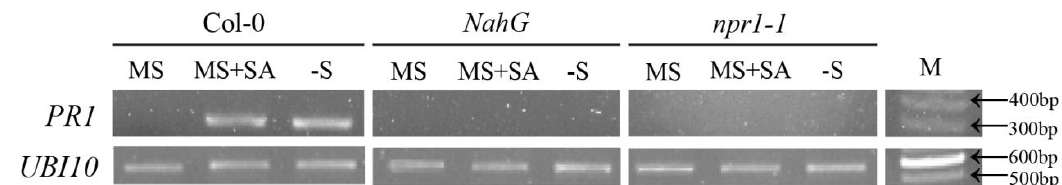
Figure 5. Gene expression analysis of PR1 in wild-type (Col-0), NahG and npr1-1 lines after treatment with ½ MS standard sulfur concentration and the sulfur deficiency (-S). UBI10 was used as a constitutive expression control gene. M, molecular weight marker.